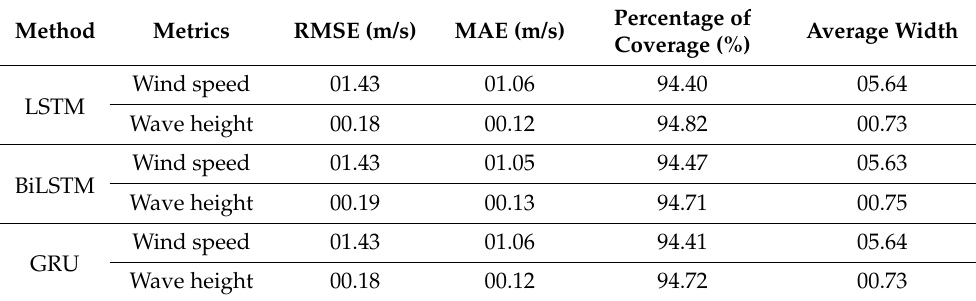
Table 3. Performance error metrics calculated